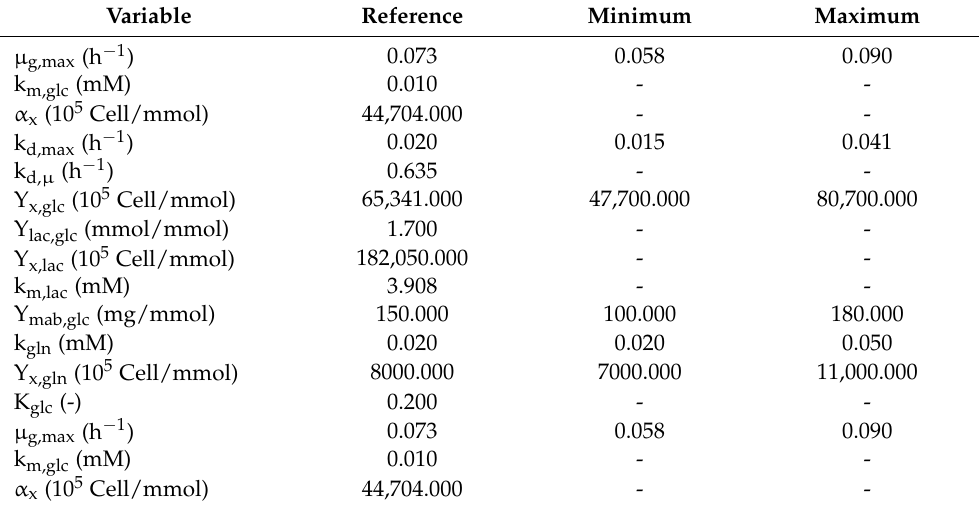
Table A2. Reference, minimum and maximum values of the parameters used for first principles in silico batches generation. Missing ranges represent that the parameter is kept constant at the reference value.